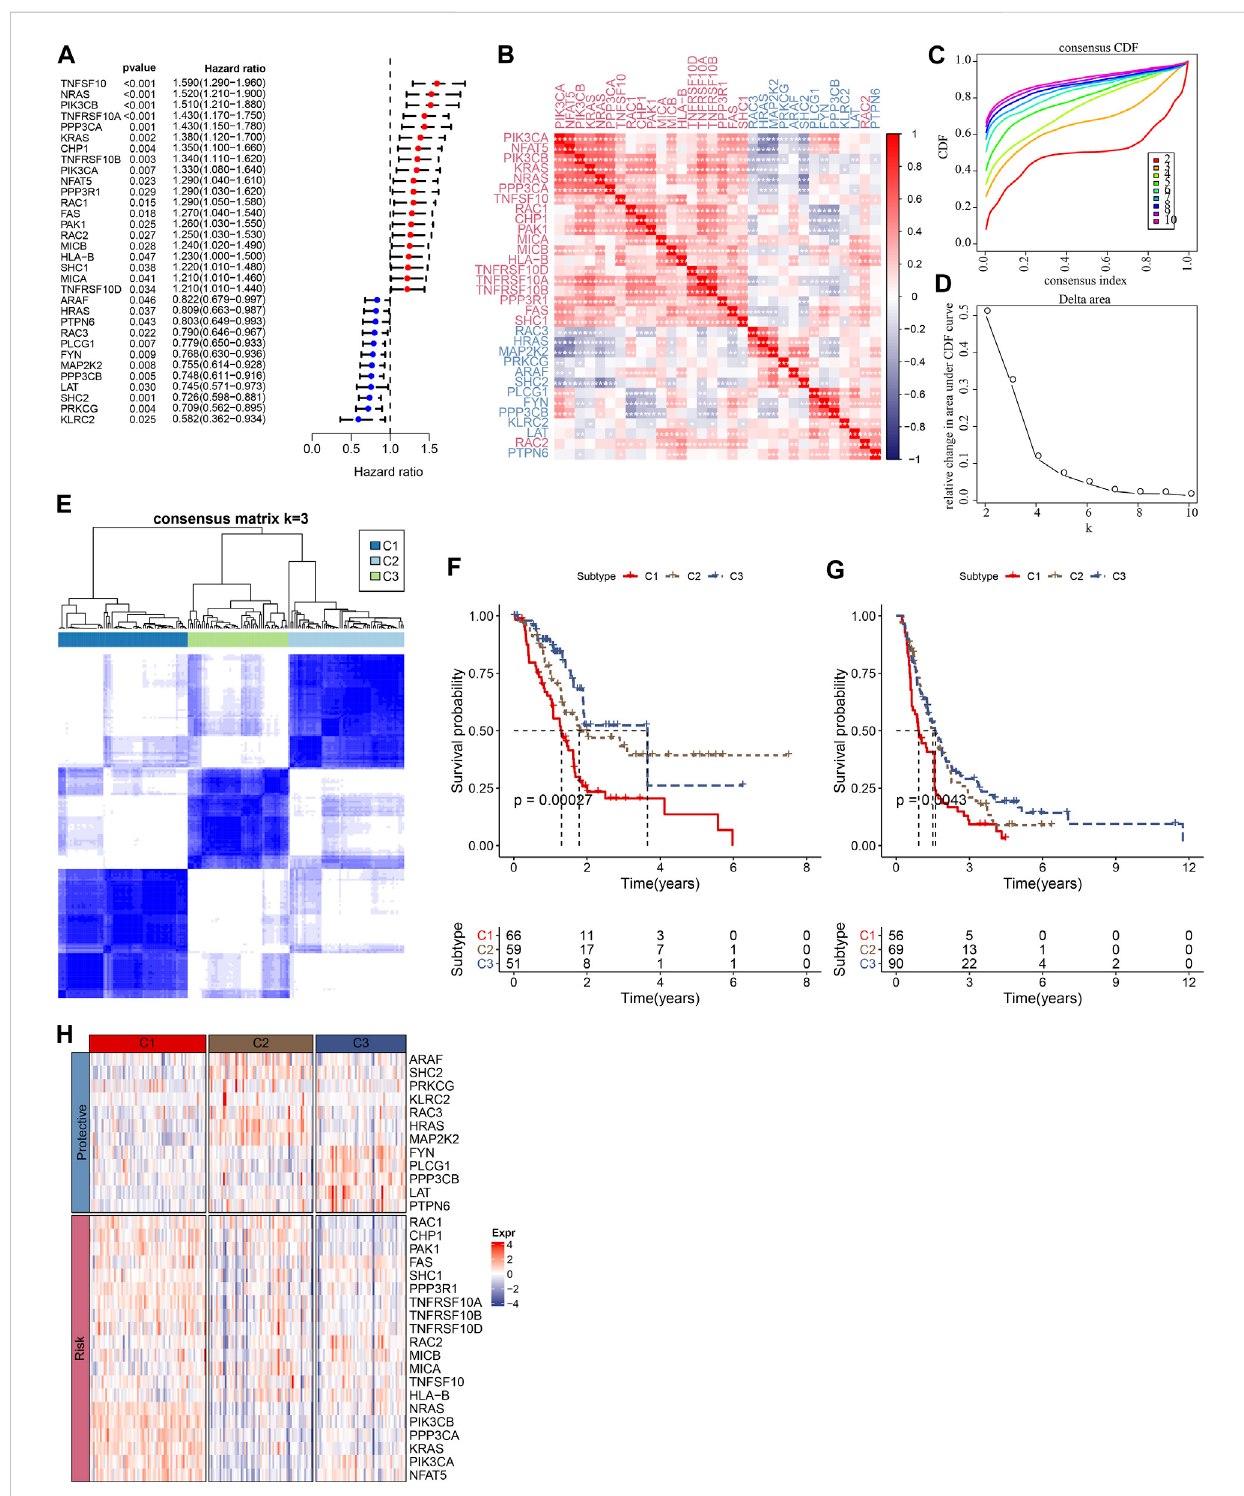
FIGURE 1 Consensus clustering of PC patients based on NKG signature. (A) Forest plot of prognosis-related NKGs in the TCGA-PAAD cohort; (B) The correlations among32prognosis-relatedNKGsintheTCGA-PAADcohort; (C) Consensuscumulativedistributionfunction(CDF)diagramwhendifferent k values, (D) Delta area plot for the relative change in the area under CDF curve for k compared to k-1, (E) Consensus matrix when the number of groups (k) = 3. In the consensus matrix, white meant that samples were impossibly clustered together, and dark blue meant that samples were always clustered together. Both rows and columns of the matrix represented samples, (F) and (G) represented the survival analysis of the clusters in the TCGA- PAAD cohort and PACA-CA cohort, respectively. (H) The heatmap of expression of 32 prognosis-related NKGs in the TCGA-PAAD